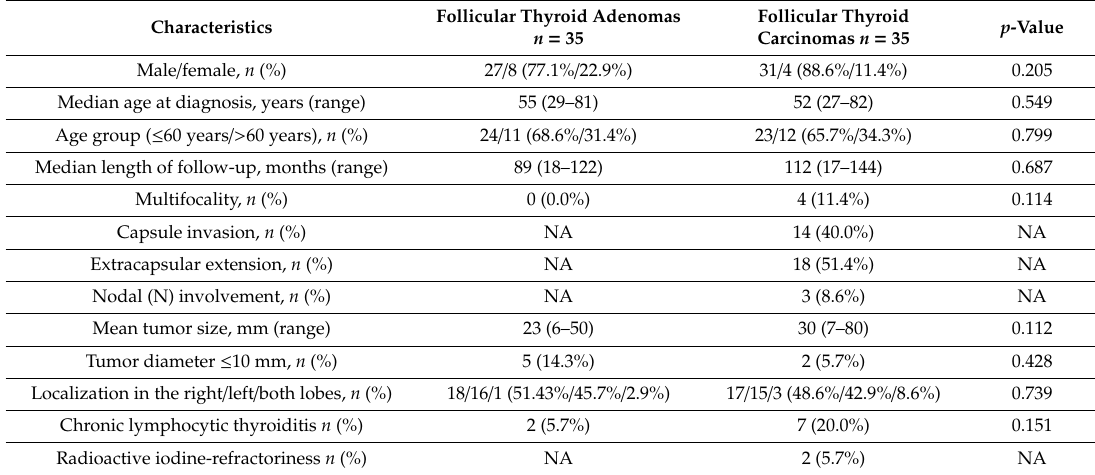
Table 5. Patients’ characteristics according to histopathological